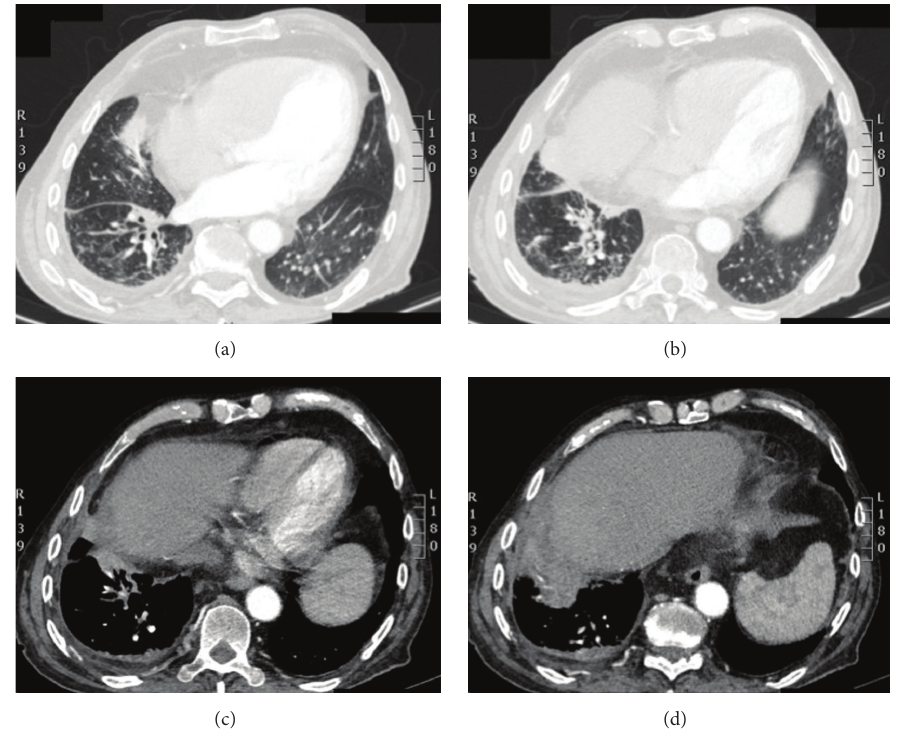
Figure 7: Control computed tomography of the chest. Almost complete resolution of the right lower lobe